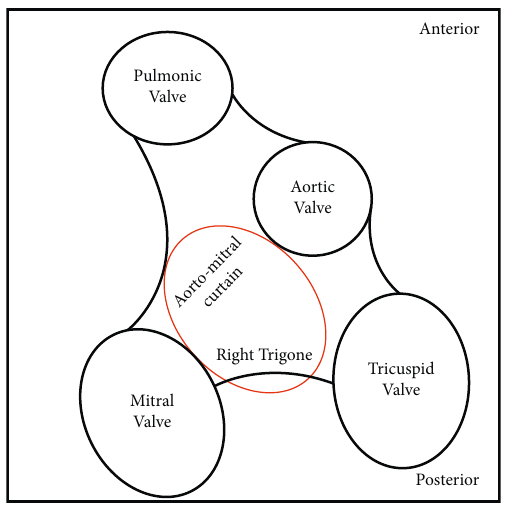
Figure 3: En face representation of the intervalvular fibrous trigone and the likely location of the injury to the area of the right fibrous trigone (red circle) that is in continuity with the LVOT and the inferior portion of the interatrial septum (Figure